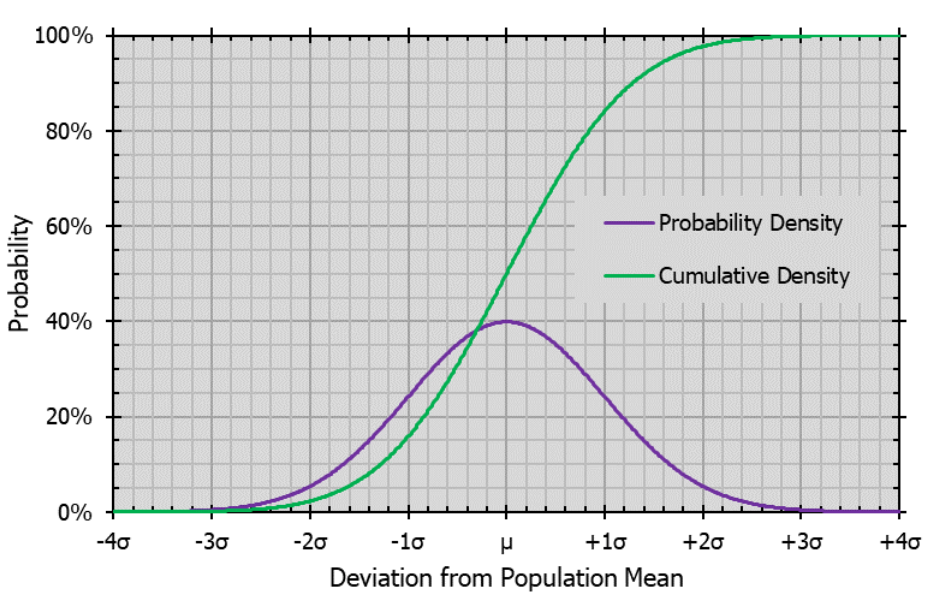
Figure 3. Normal